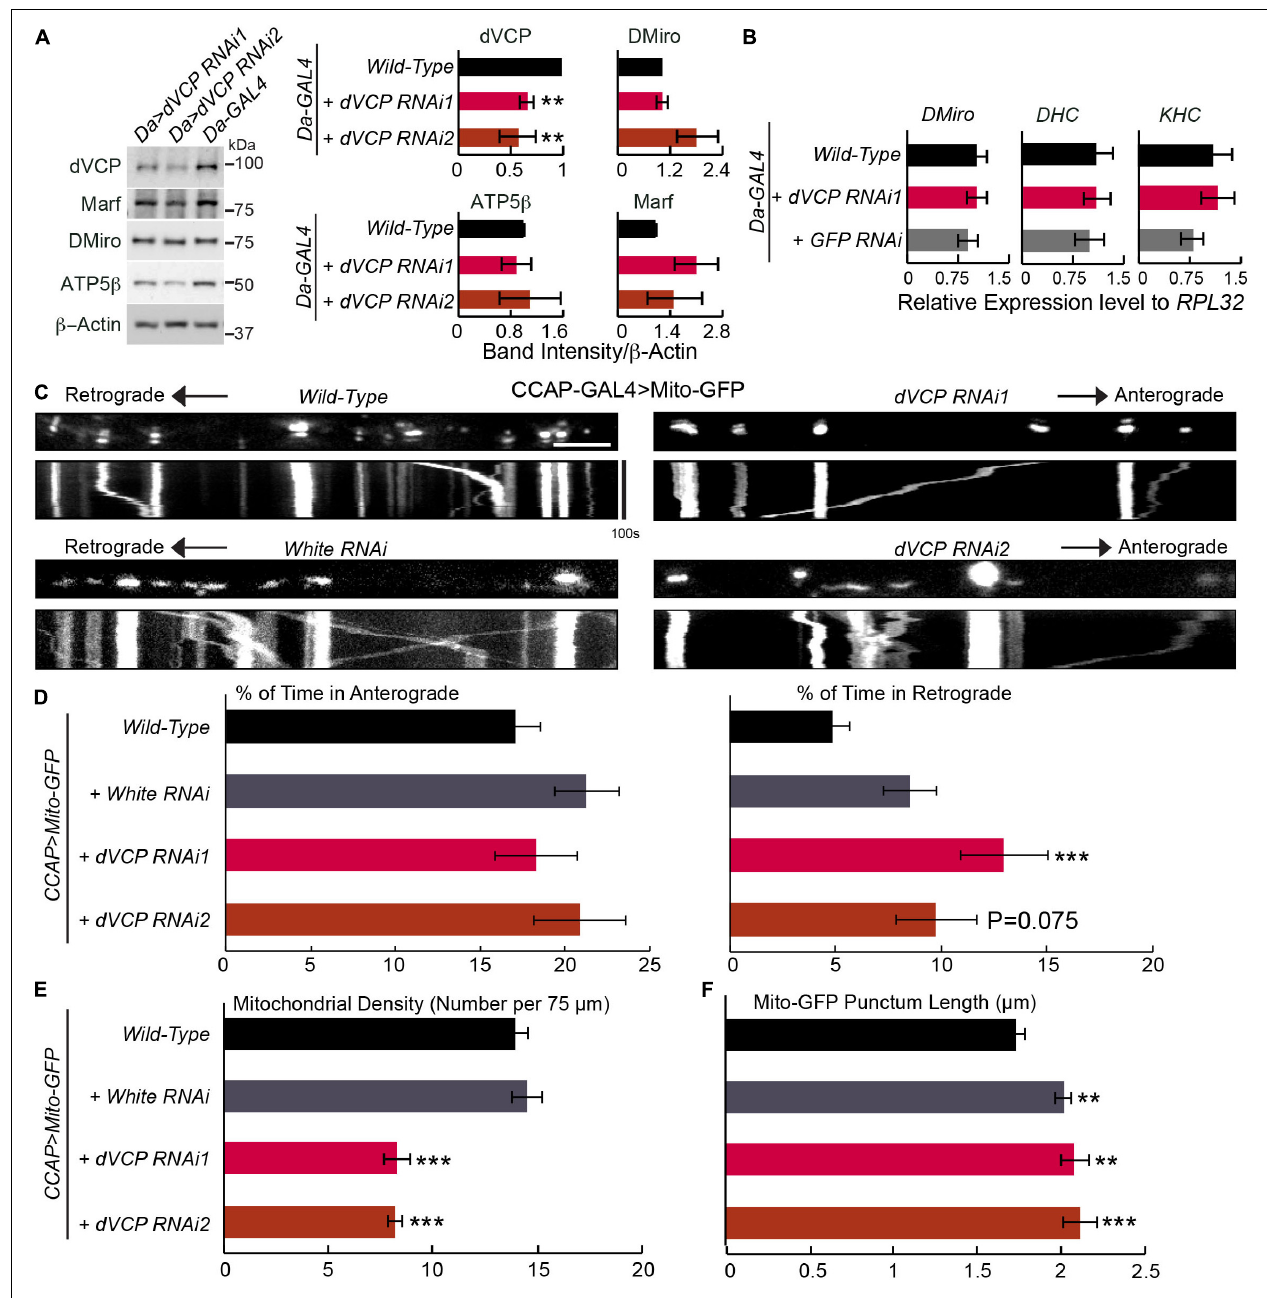
FIGURE 1 | Knockdown of dVCP alters axonal transport of mitochondria. (A) Whole body lysates from adult flies five days after eclosion were immunoblotted as indicated. Protein band intensities are normalized to those of β -actin and graphed as relative change compared to “ Da-GAL4 > Wild-Type .” β -Actin levels are not significantly different among all genotypes. n = 3–6 independent experiments. (B) The mRNA expression levels were detected by qPCR on third instar larvae using primers amplifying genes as indicated, normalized to the expression levels of RPL32 within the same experiment ( n = 4 independent experiments). (C–F) Mitochondrial motility parameters are extracted from live imaging movies of mitochondria in larval CCAP-GAL4 expressing axons passing segment A3. (C) Mitochondrial movement labeled by Mito-GFP driven by CCAP-GAL4. The first frame of each live imaging series is shown above a kymograph generated from the movie. The x -axis of each kymograph is mitochondrial position, and the y -axis corresponds to time (moving from top to bottom). Vertical white lines represent stationary mitochondria and diagonal lines are moving mitochondria. (D) From kymographs as in C , the percent of time each mitochondrion is in motion in the anterograde and retrograde directions is determined and averaged ( n = 164–334 mitochondria). (E) From kymographs as in C , the number of mitochondria present per 75 µ m axon is quantified ( n = 20–23 axons). (F) The length of each Mito-GFP punctum is quantified and averaged ( n = 164–334 mitochondria). For D–F , 20–23 axons were imaged from 7 to 10 larvae per genotype. Comparisons with “ CCAP-GAL4 > Mito-GFP, Wild-Type ”. Scale bar = 7.5 µ m. ** P < 0.01, *** P < 0.001, and error bars represent mean ± SEM here and for all figures.